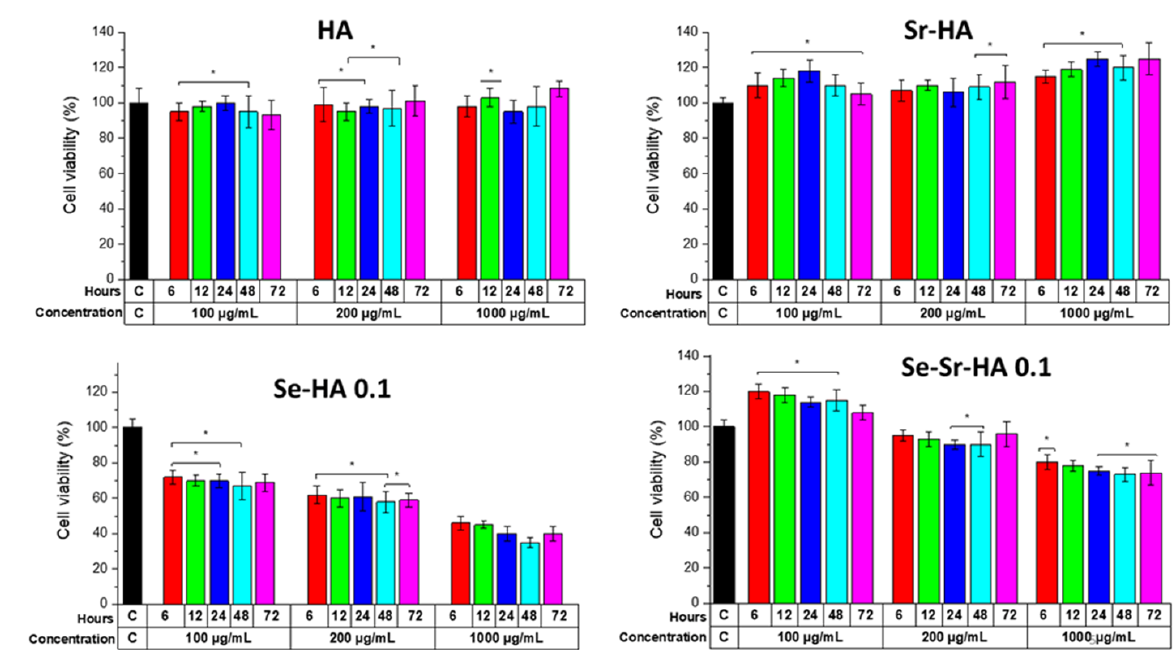
Figure 9. Osteoblast-like human cell (MG-63) response to three different concentrations of supernatants (100 µ g · mL − 1 , 200 µ g · mL − 1 , and 1000 µ g · mL − 1 ) of HA, Se-HA, Se-Sr-HA, and Sr-HA taken at different time points (6, 12, 24, 48, and 72 h) measured by WST-8 up to 2 days of culture. Tissue culture plates made up of polystyrene (PS) were used as control (C). The resultant cell viability for each material was normalized against the viability of cells on PS at a particular day (data represent the mean ± standard deviation of two individual experiments each performed in pentaplicate) (* p < 0.05).